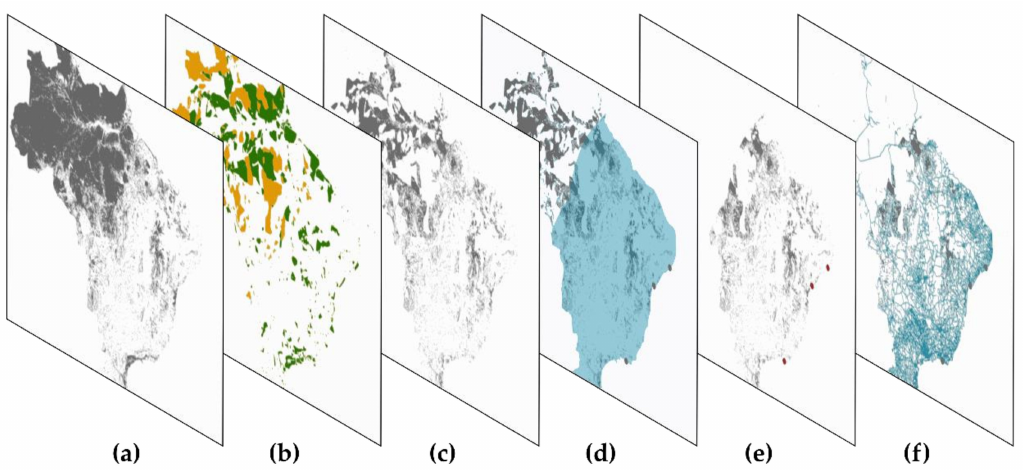
Figure 3. ( a ) Example of forestry feedstock availability calculation for Brazil, based on total area classified as forest vegetation by the Instituto Brasiliero de Geografia e Estatistica [65]; ( b ) Protected areas (green) and areas inhabited by indigenous people (orange), were based on data from [66–68]; ( c ) Forestry feedstock availability minus protected areas as shown in ( b ); ( d ) Only the areas within 2000 km from selected export ports were considered feasible for mobilization; ( e ) The resulting remaining potential areas for pellet production; ( f ) As the final step, OpenStreetMap road infrastructure, adapted from [64], was used to calculate transport